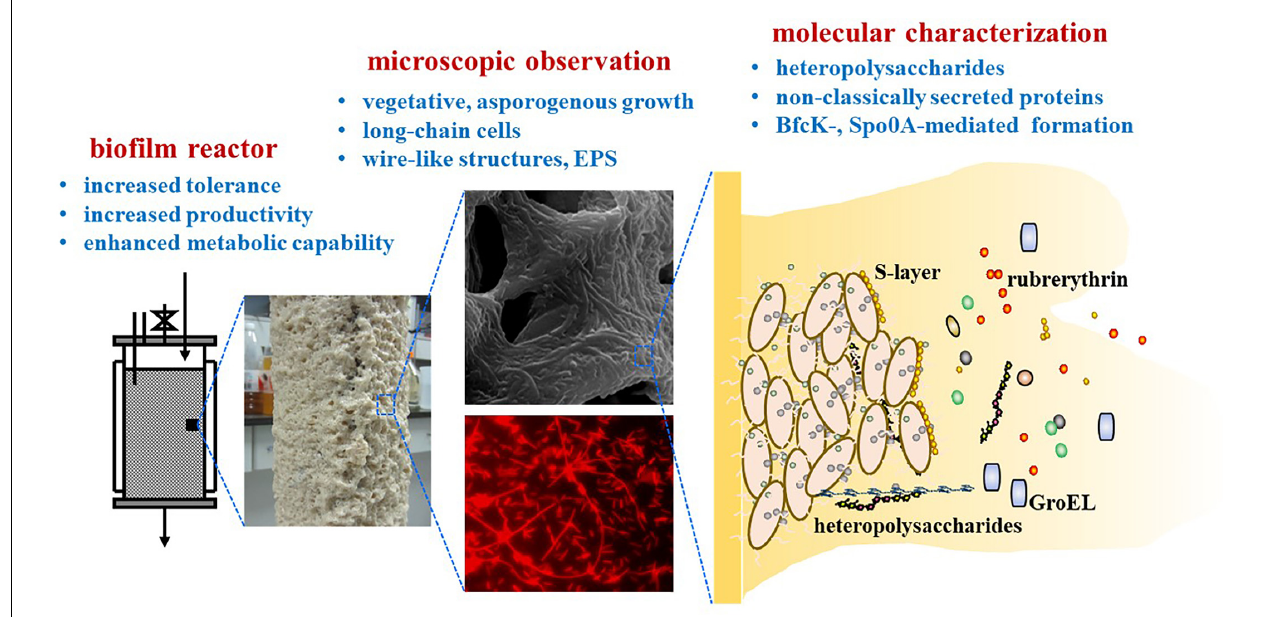
FIGURE 1 | Characterized aspects of C. acetobutylicum